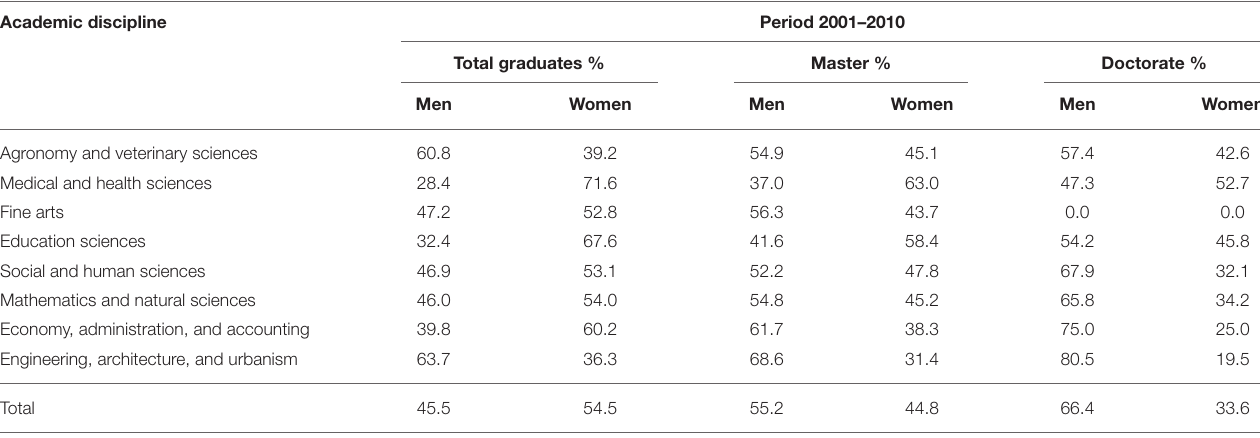
TABLE 1 | Percentage of total graduates from undergraduate and graduate programs at higher education institutions in Colombia, divided by gender and academic discipline for the time (2001–2010).